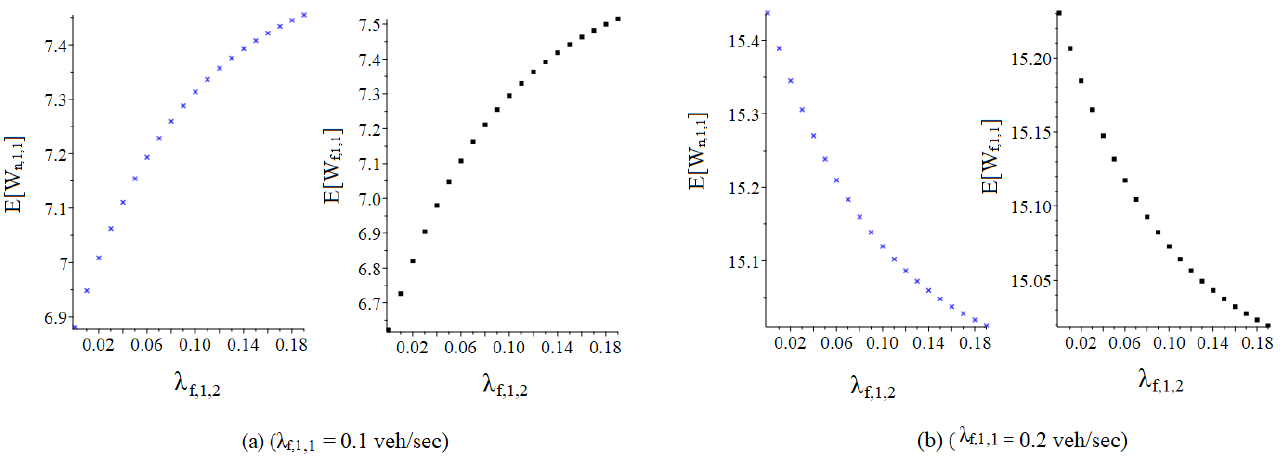
Figure 5. Expected waiting times of vehicles in a lane on the main road as functions of the arrival rate of freight vehicles in the opposite